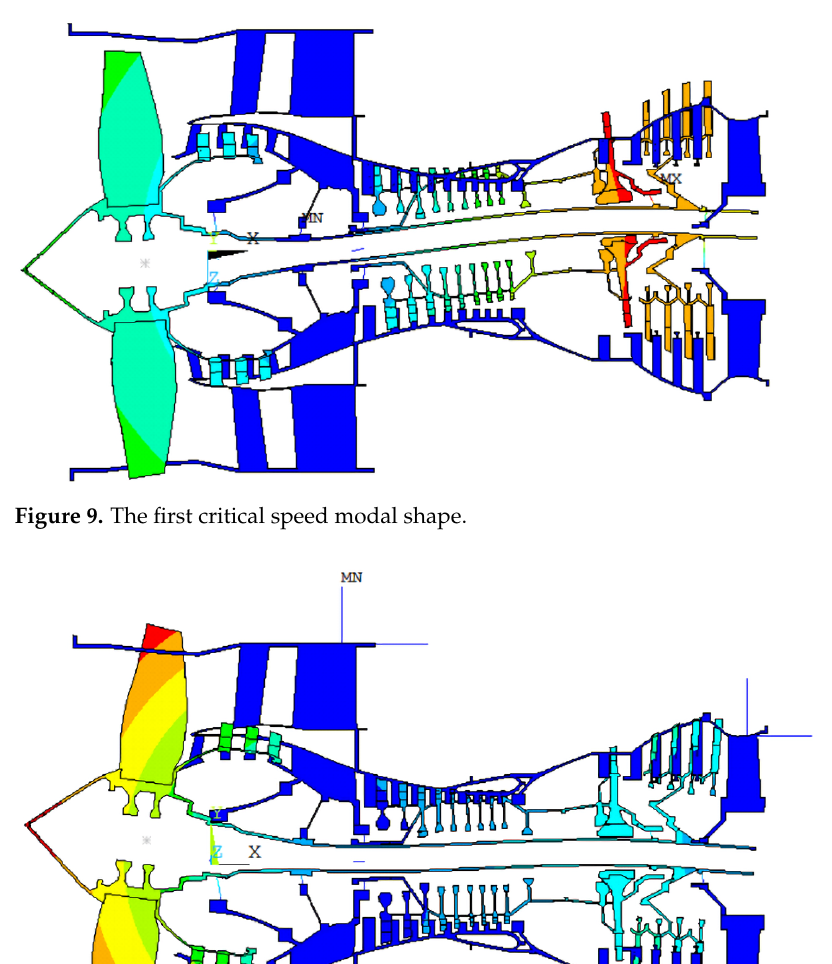
Figure 9. The first critical speed modal shape.